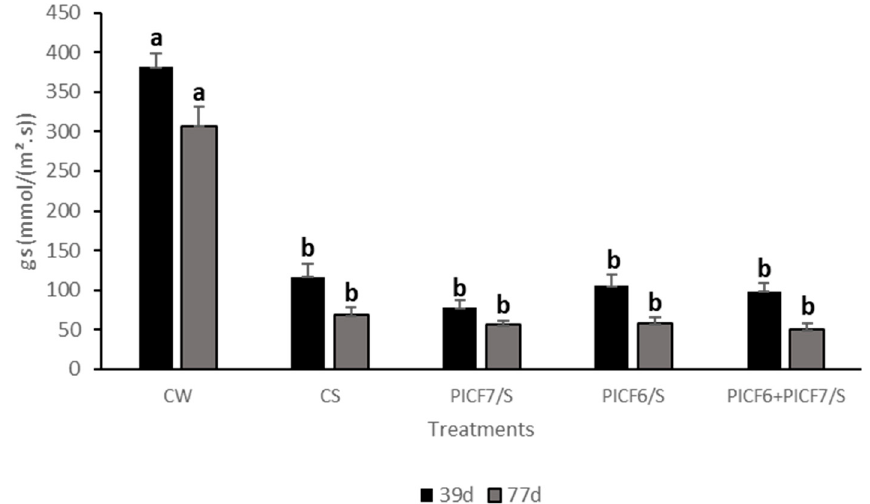
Figure 9. Stomatal conductance (gs) in olive plants cv. Picual. CW, control plants just irrigated with distilled water; CS, plants treated with salt (S) solution; PICF7/S, plants inoculated with Pseudomonas simiae PICF7 and treated with S solution; PICF6/S, plants inoculated with Pseudomonas sp. PICF6 and treated with S solution; PICF6+PICF7/S plants co-inoculated with strains PICF6 and PICF7 and treated with S solution. Error bars represent the standard error of the means ( n = 9). Letters represent significantly ( p < 0.05) differences among treatments at the same sampling time according to Tukey (HDS) test. Experiment was performed twice with similar results.